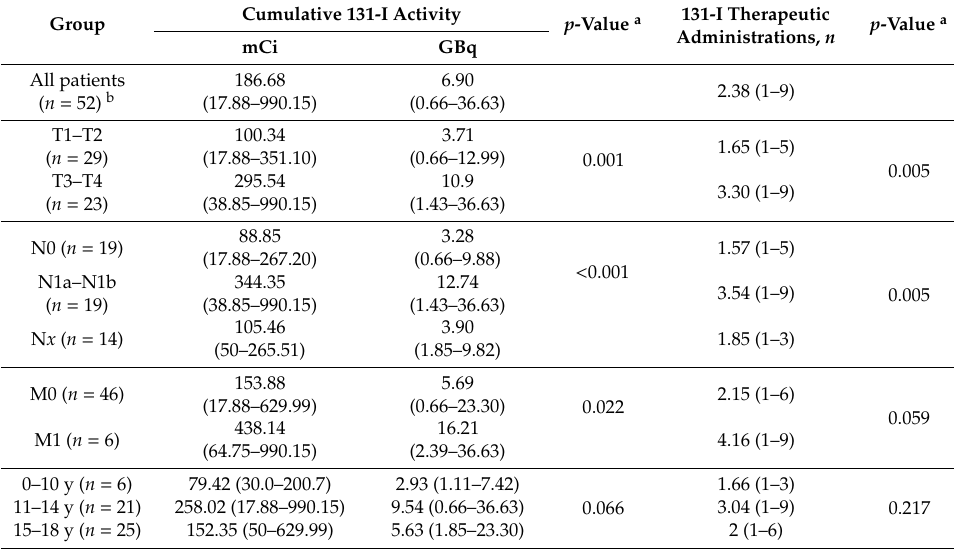
Table 4. Administration of